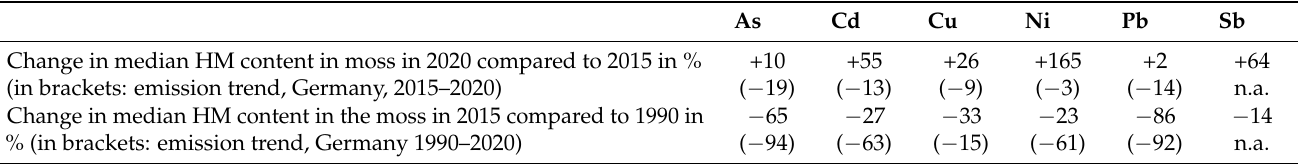
Table 6. Median values of metal concentrations in mosses compared to metal emissions in Germany